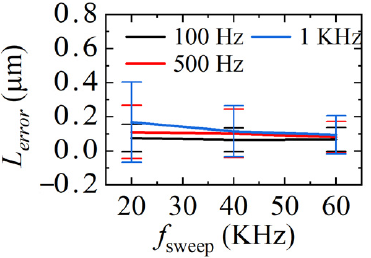
Figure 15. Errors at sweeping rates of ( a ) 20 KHz, ( b ) 40 KHz, and ( c ) 60 KHz, respectively.